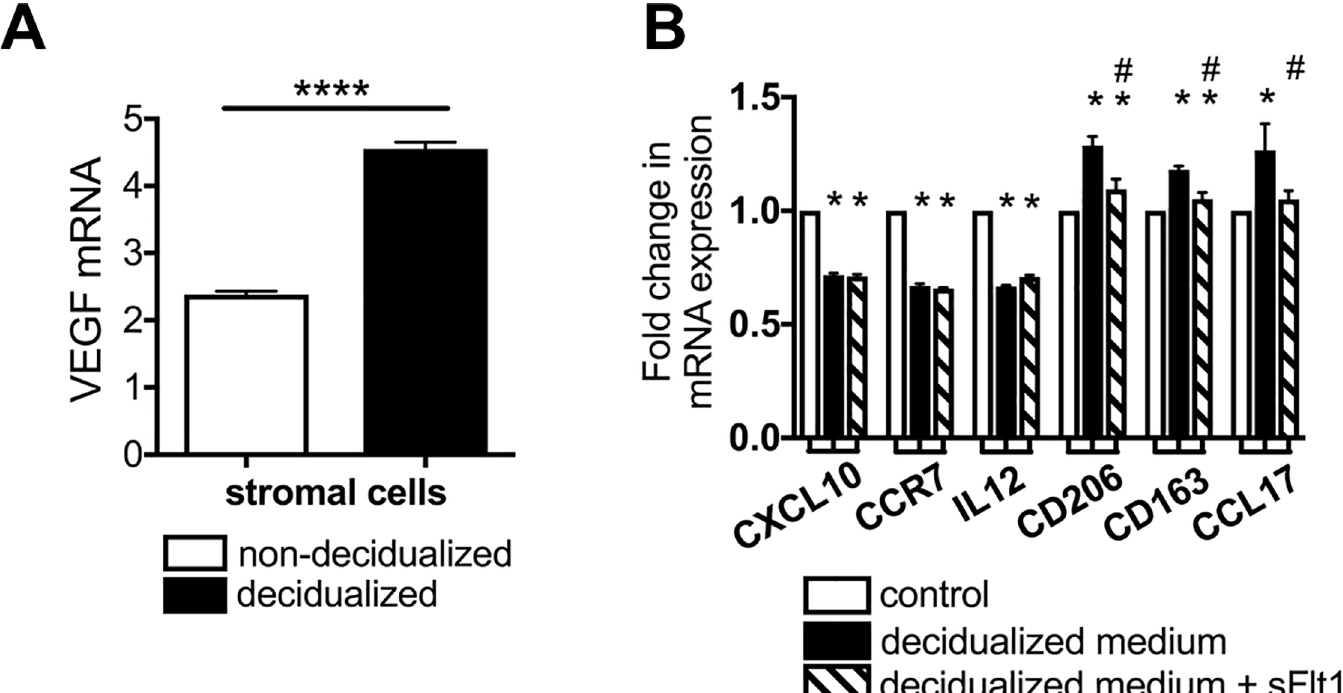
Fig 4. Decidual endometrial stromal cells produce VEGF and stimulate M2 macrophage polarization. A, qPCR analysis of VEGF mRNA expression in decidualized and non-decidualized stromal cells. VEGF expression is highly significantly increased following decidualization. B, expression of M1 and M2 mRNA markers following treatment with conditioned medium from decidualized/non-decidualized stromal cells, with or without the VEGF inhibitor sFlt1. Decidualized stromal cell conditioned medium induces a significant decrease in all M1 markers and a significant increase in all M2 markers, but the effect of the conditioned medium on M2 markers was abrogated by sFlt1 treatment, suggesting a potential role for VEGF in M2 polarization. Graphs represent means ±standard errors; (cid:3) = p < 0.05 compared to controls; # = p < 0.05 compared to decidualization medium; (cid:3)(cid:3)(cid:3)(cid:3) = p < 0.0001.